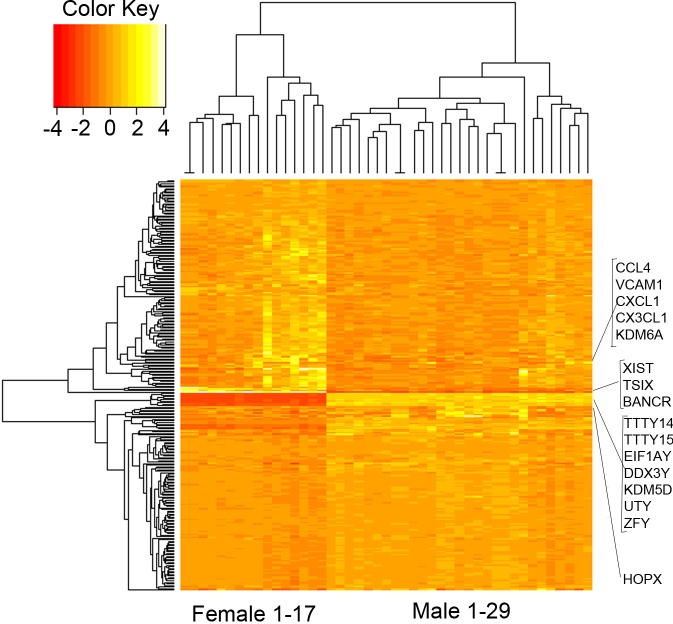
Differentially expressed genes heat map.Heat map showing differentially expressed genes between male and female LV tissues.